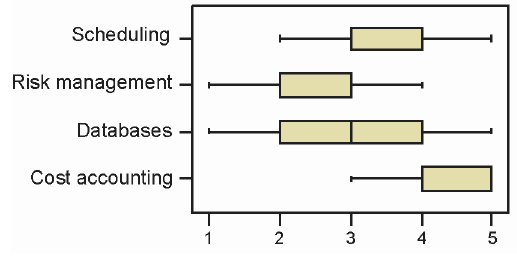
Fig. 5. Risk management element usage in PPP projects